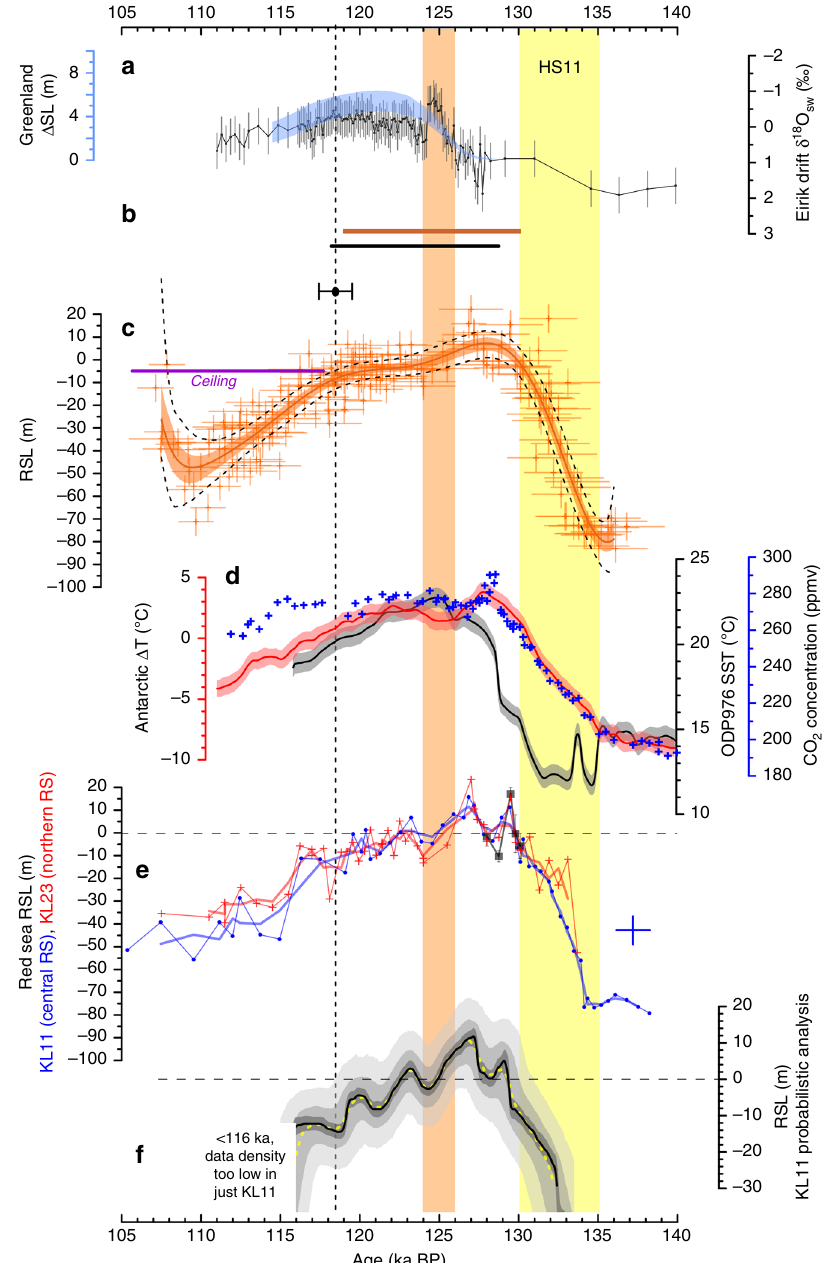
Fig. 2 Variability in Last Interglacial sea-level time-series. Yellow bar: time-interval of Heinrich Stadial 11 (HS11) 19 . Orange bar: approximate interval of temporary sea-level drop in various records. Dashed line: end of main LIG highstand set to 118.5 ka (cross-bar indicates 95% con fi dence limits of ±1.2 ka), based on compilations in b and the speleothem sea-level “ ceiling ” ( c ). a GrIS contributions to sea level from a model-based assessment of Greenland ice- core data (blue) 9 , and changes in surface sea-water δ 18 O at Eirik Drift (black; this study) with uncertainties (2 σ ) determined from underpinning δ 18 O and Mg/Ca measurement uncertainties and Mg/Ca calibration uncertainties. b Ninety- fi ve per cent probability interval for coral sea-level markers above 0 m 11 (brown), and LIG duration from a previous compilation (black) 26 . c Red Sea RSL stack (red, including KL23) with 1 σ error bars. Smoothings are shown to highlight general trends only, and represent simple polynomial regressions with 68% and 95% con fi dence limits (orange shading and black dashes, respectively). Purple line indicates the sea-level “ ceiling ” indicated by subaerial speleothem growth (Yucatan) 24 . d Probability maximum (PM, lines) and its 95% con fi dence interval for Antarctic temperature changes (red) 68 , and proxy for eastern Atlantic water temperature (ODP976, grey) 69 . Blue crosses: composite record of atmospheric CO 2 concentrations from Antarctic ice cores 19 . e Individual records for Red Sea cores KL11 (blue, dots) and KL23 (red, plusses), with 300-year moving Gaussian smoothings (as used in ref. 1 ). Also shown is a replication exercise to validate the single-sample earliest-LIG peak in KL23 (grey, fi lled squares) with 1 standard error intervals (bars, σ / √ { N }, based on N = 5, 5, 4, 4, and 5 replications, from youngest to oldest sample, respectively). Separate blue cross indicates typical uncertainties (1 σ ) in individual KL11 datapoints prior to probabilistic analysis of the record. f Probabilistic analysis of the KL11 Red Sea RSL record, taking into account the strict stratigraphic coherence of this record. Results are reported for the median (50th percentile, dashed yellow), PM (modal value, black), the 95% probability interval of the PM (dark grey shading), and both the 68% and 95% probability intervals for individual datapoints (intermediate and light grey shading,